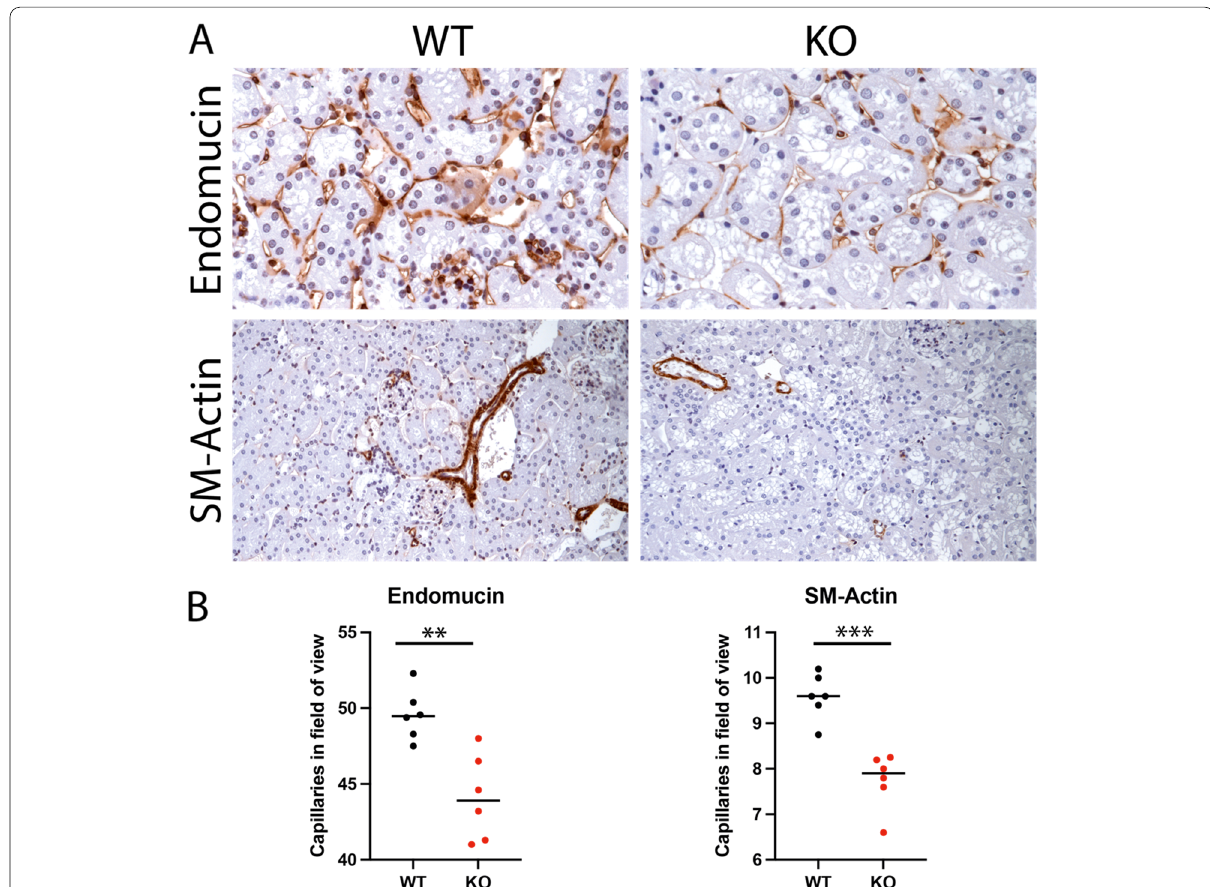
Fig. 4 Immunohistochemistry for vascular markers of WT compared to KO mice . A Exemplary immunohistochemistry stainings for endomucin (capillaries, brown staining) and smooth muscle actin (SM-Actin, arterioles, brown staining). Left panel indicated WT and right panels KO. B Quantification of positive stained vessels in the field of view. Differences were tested with parametric two-sided t test. * WT wildtype genotype, KO knock-out = =